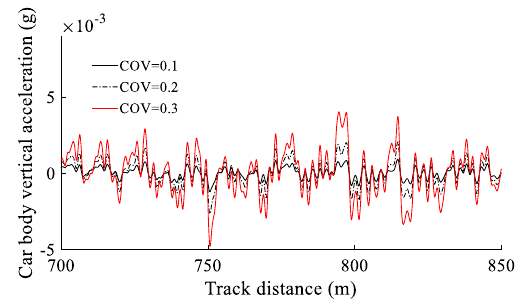
Fig. 15 Car body vertical